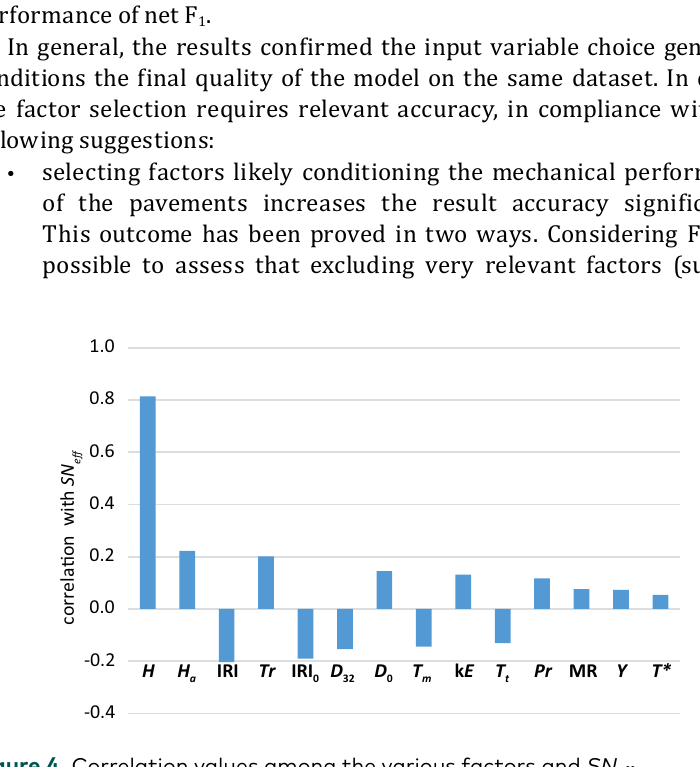
Figure 4. Correlation values among the various factors and SN eff